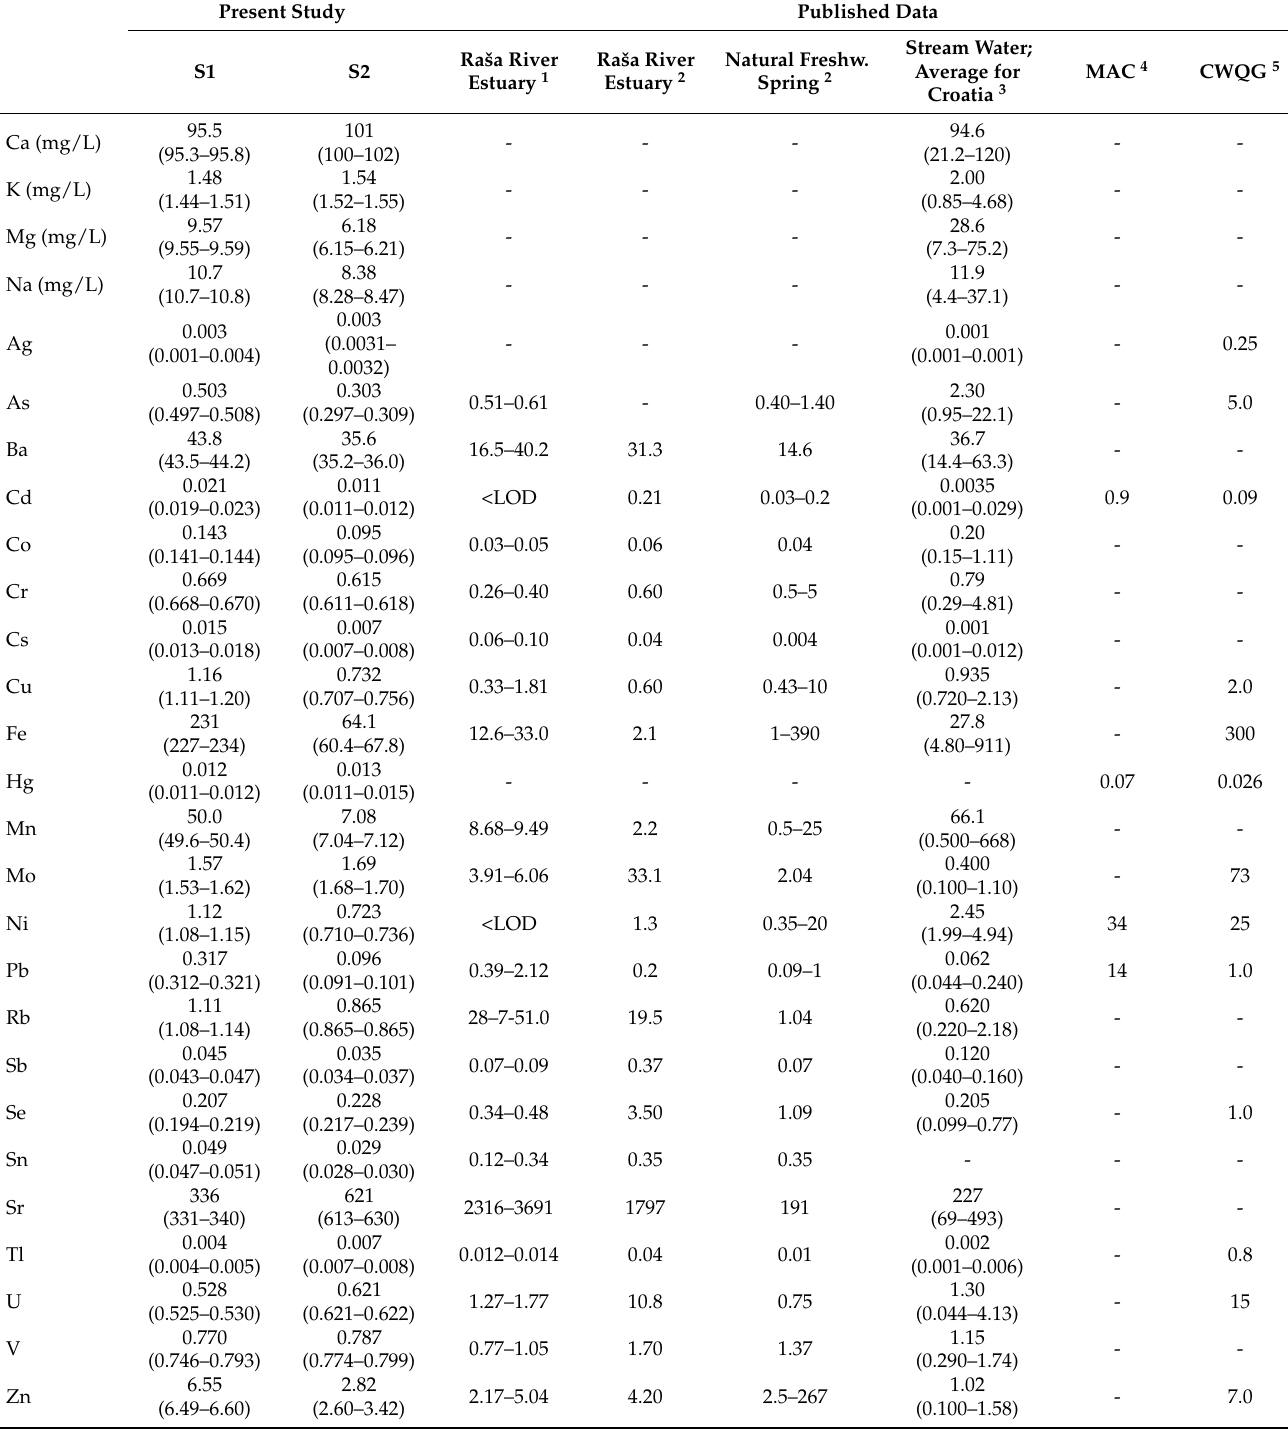
Table 2. Comparison of average levels (median (range)) of elements (in µ g/L unless otherwise stated) in unfiltered water samples collected in June and July of 2020 at 2 locations in the Raša River with the relevant published data ( 1–3 ) and water quality guidelines ( 4,5